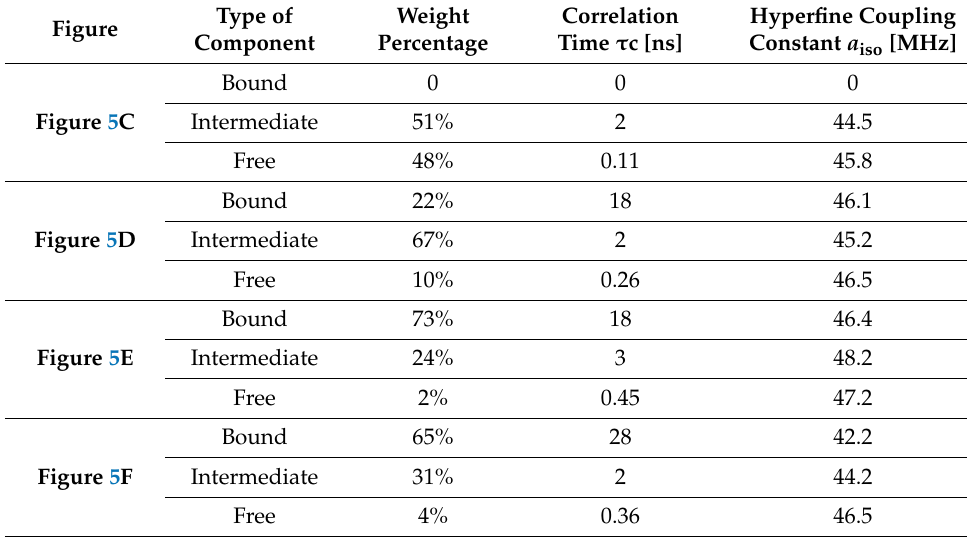
Table 1. Parameters of spectral simulation of Figure 5.